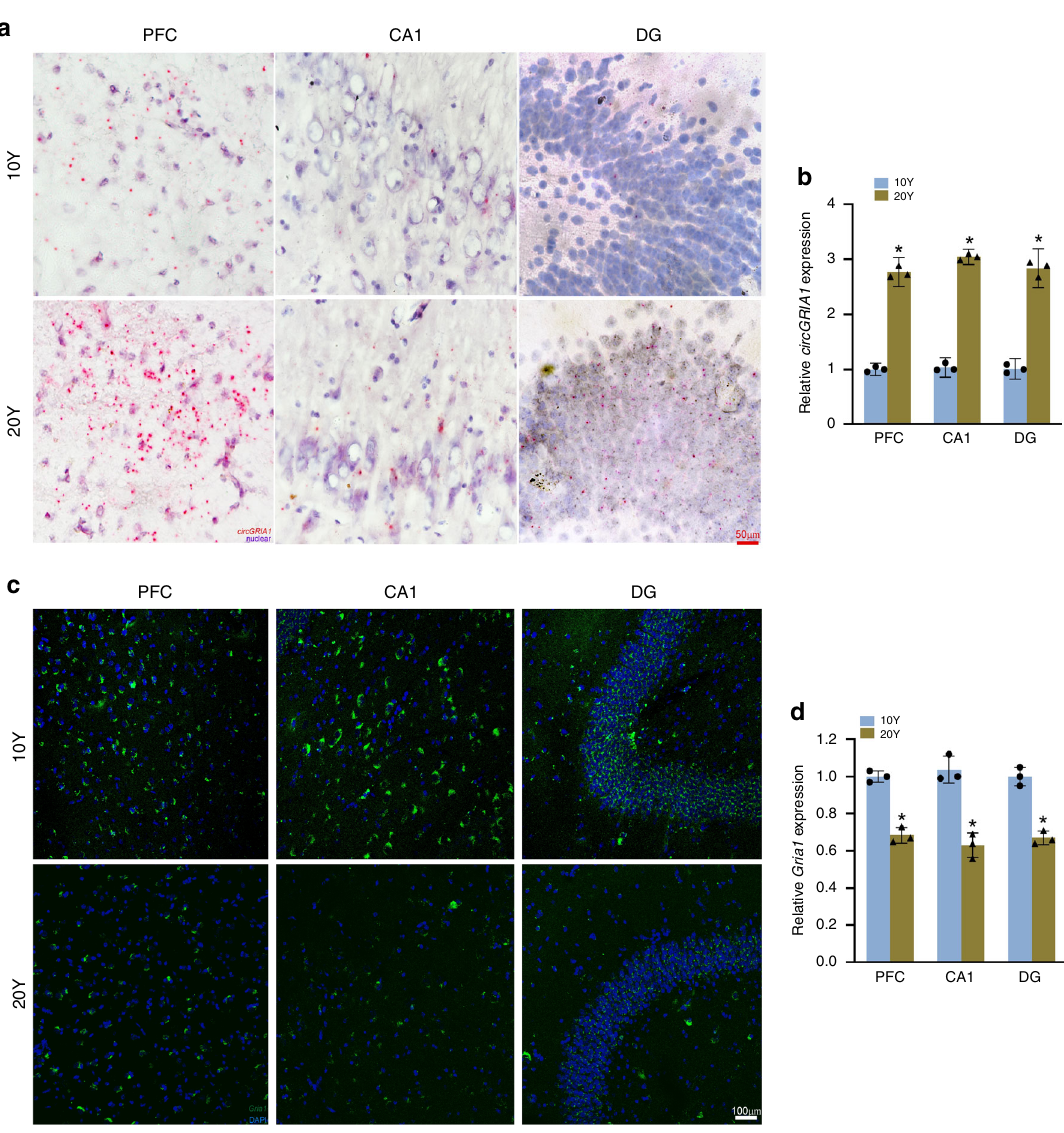
Fig. 2 Negative correlation between CircGRIA1 and Gria1 mRNA expression. a Representative images of BASEscope in situ hybridization (ISH) showing circGRIA1 expression in PFC and hippocampus (CA1 and DG) of 10-Y and 20-Y male macaques . The images are representative of three independent experiments of each sample from 2 to 3 animals per age group. Red dots indicate circGRIA1 with nuclei counterstaining by hematoxylin. Scale bar, 50 μ m. b Relative intensities of BASEscope ISH signals of circGRIA1 illustrated in ( a ) were quanti fi ed by use of Image J. Data are present as mean ± S.D. ( n = 45 – 60 cells per age group; * p < 0.05, unpaired t- test). c Representative images of RNAscope ISH showing Gria1 expression in PFC and hippocampus of 10-Y and 20-Y male macaques . The images are representative of three independent experiment of each sample from 2 to 3 animals per age group. Green dots indicate Gria1 mRNA with nuclei counterstaining by DAPI. Scale bar, 100 μ m. d Relative intensities of RNAscope ISH signals of Gria1 illustrated in ( c ) were quanti fi ed by use of Image J. Data are present as mean ± S.D. ( n = 50 – 65 cells per age group; * p < 0.05, unpaired t- test). Source data are provided as a Source Data fi